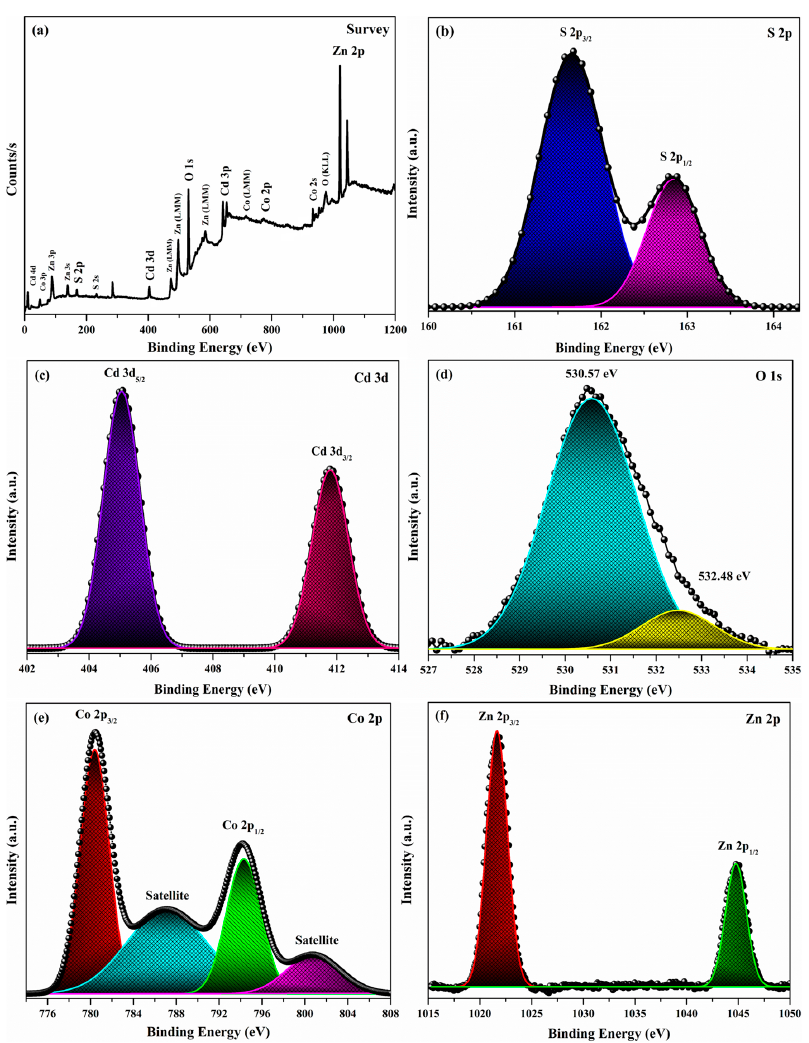
Figure 4. XPS spectra of Co-doped ZnO/CdS nanosheets. ( a ) Survey, ( b ) S 2p, (c) Cd 3d, ( d ) O 1s, ( e ) Co 2p, and ( f ) Zn 2p.